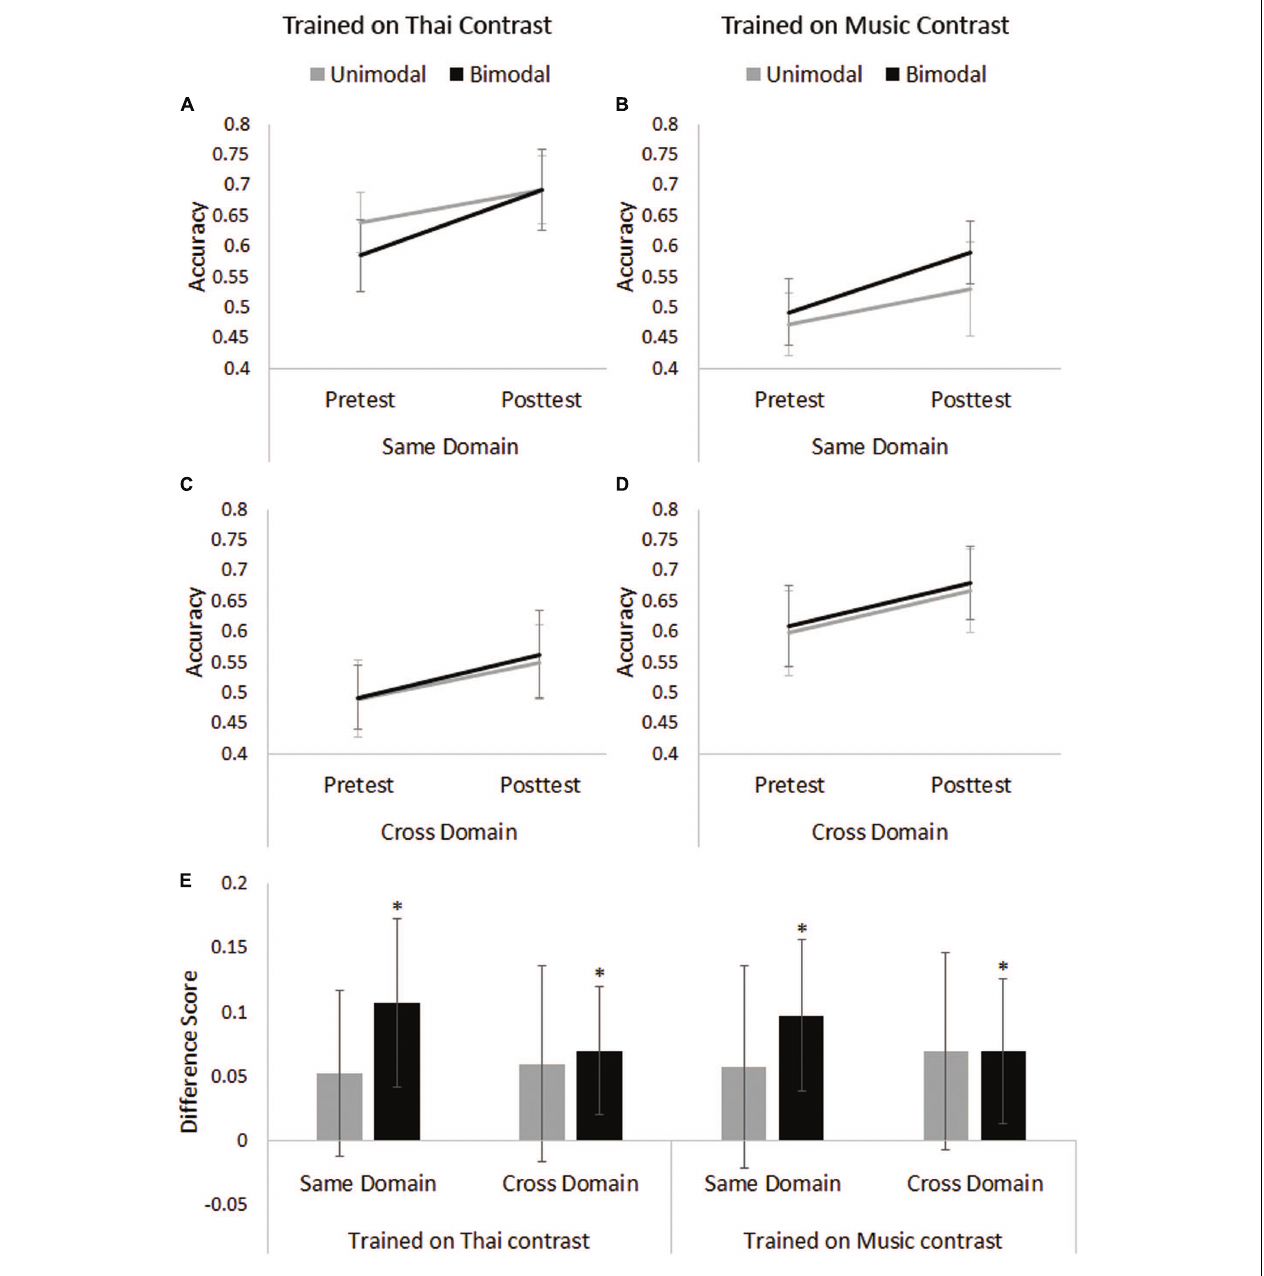
FIGURE 2 | Pretest and Posttest performance by Training Domain and Distribution Condition for (A) same domain test items by Thai group; (B) same domain test items by Music group; (C) cross-domain test items by Thai group; and (D) cross-domain test items by Music group; (E) difference scores (Posttest–Pretest) on the same and cross-domain test items by Training Domain and Distribution Condition. Asterisks indicate significant improvement after Holm–Bonferroni correction. Error bars represent 95% confidence